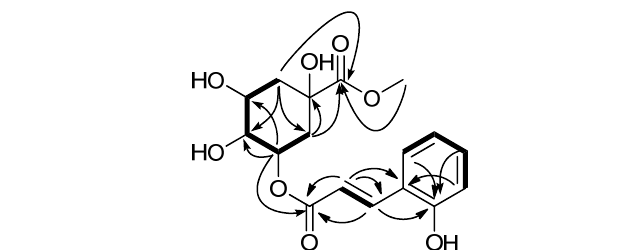
Figure 2. Key HMBC ( ) and COSY ( ) correlations of compound 1 .